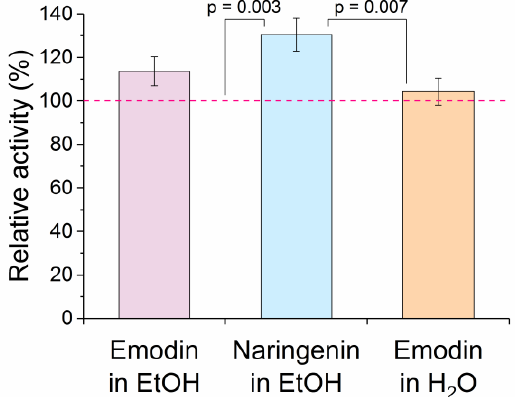
Figure 6. Influence of ethanol and water solutions of emodin as well as ethanol solution of naringenin on activity of His 6 -OPH. Activity of the enzyme under the same conditions (i.e., with 0.5% EtOH but without effectors for alcohol solutions) was considered 100% (dashed line). Emodin and naringenin were added into reaction mixtures at a ratio of 2 and 18 molecules per His 6 -OPH dimer, respectively. There was a statistically significant difference (N = 3, one-way ANOVA, p = 0.002) and pairs within the significance level (0.05) are labeled. Differences for all other pairs were statistically non-significant ( p > 0.05) by the Holm – Sidak method of multiple pairwise comparisons.